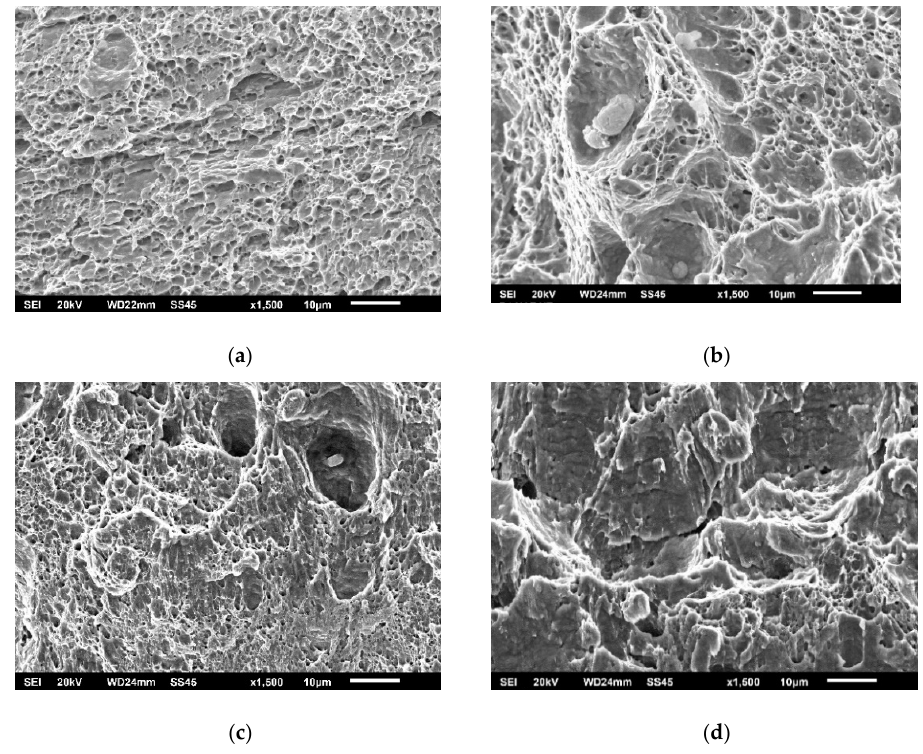
Figure 10. SA ‐ 387 Gr. 91 HAZ fractography upon ( a ) crack initiation, 575 °C; ( b ) crack propagation, 575 °C; ( c ) crack initiation, 20 °C; and ( d ) crack propagation, 20 °C.